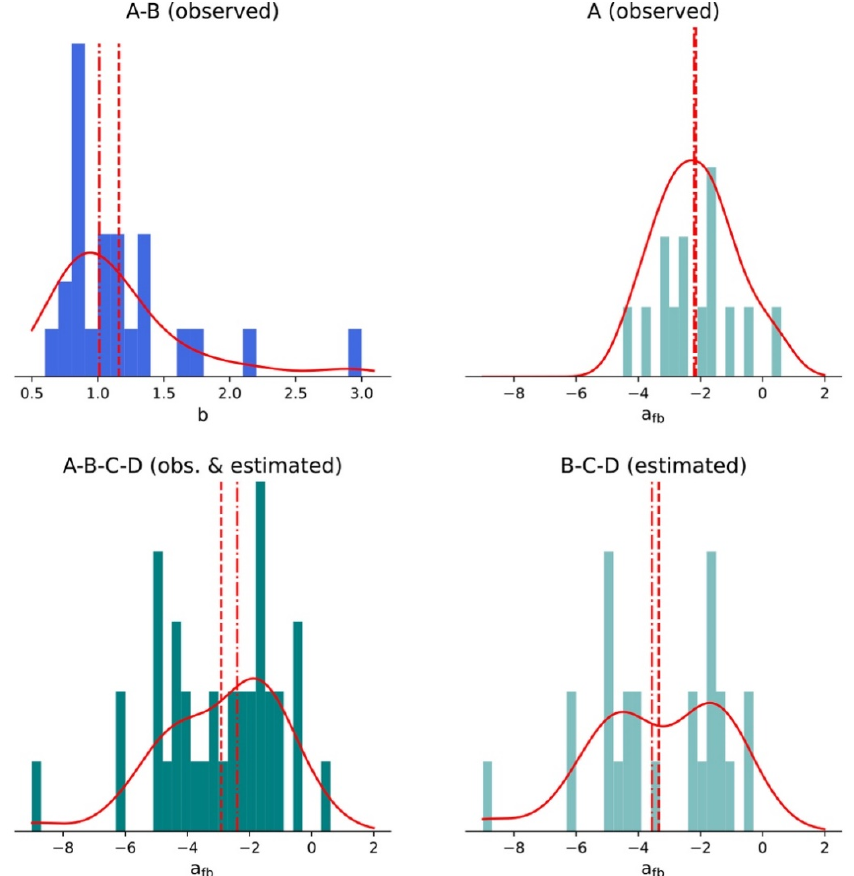
Figure 2. Empirical distributions of the seismic hazard parameters b and a fb derived from the meta-analysis of 39 fluid injections in the geothermal context. Gaussian density kernels are represented by red curves, mean estimates by red dotted lines and median estimates by red dashed lines.